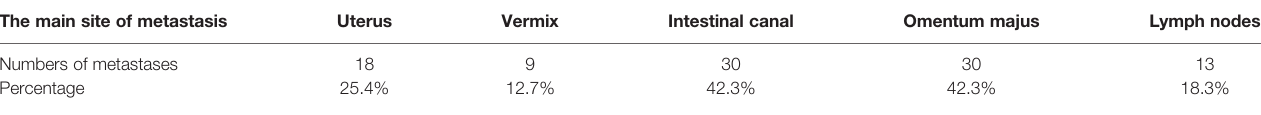
TABLE 2 | The main metastatic sites and number of metastases of enrolled patients with ovarian cancer. The main site of